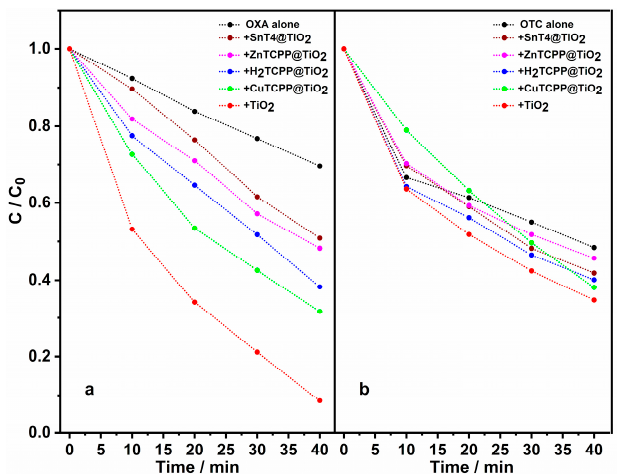
Figure 4. Photodegradation rates as function of C/C 0 vs irradiation time for OXA (panel a , λ max = 338 nm) and OTC (panel b , λ max = 359 nm): alone (black dots) and in the presence of SnT4@TiO 2 (wine dots), ZnTCPP@TiO 2 (purple dots), H 2 TCPP@TiO 2 (blue dots), CuTCPP@TiO 2 (green dots) naked TiO 2 (red dots). In all experiments, the antibiotics’ initial concentration was 30 µM at pH = 7.0, and the amount of photocatalyst used was 1 mg.